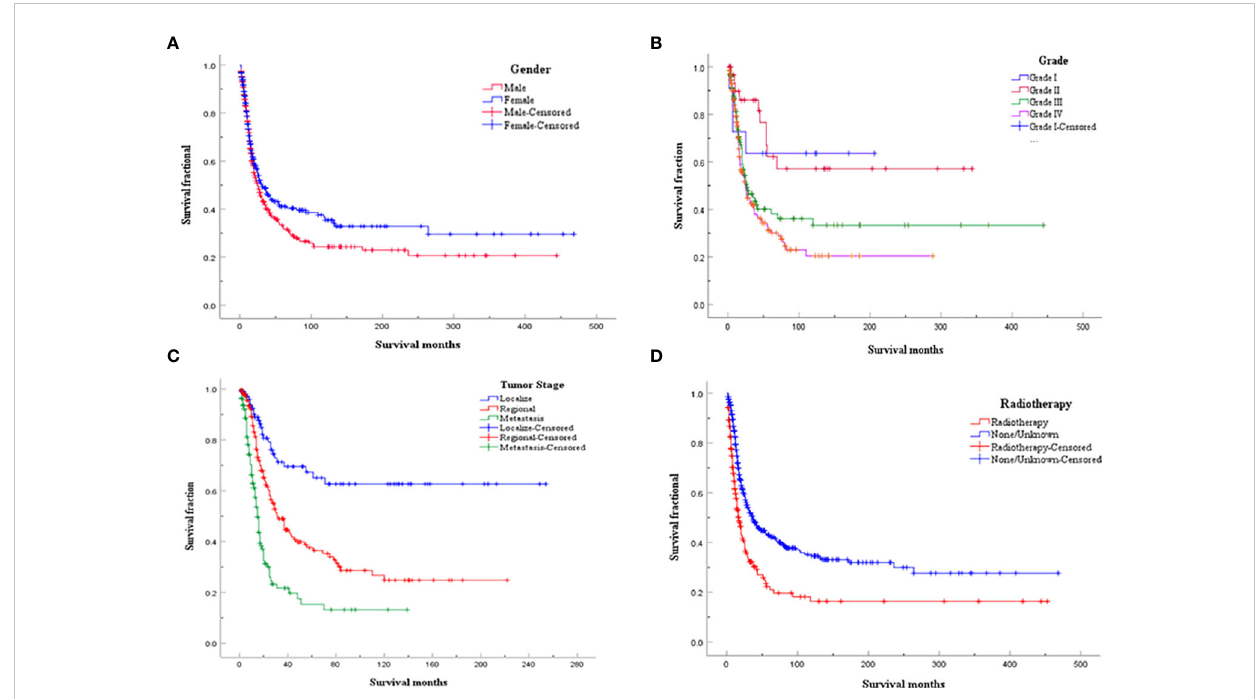
FIGURE 2 Kaplan-Meier analysis for DDS of spinal osteosarcoma according to (A) gender; (B) Tumor grade; (C) Tumor stage; (D)